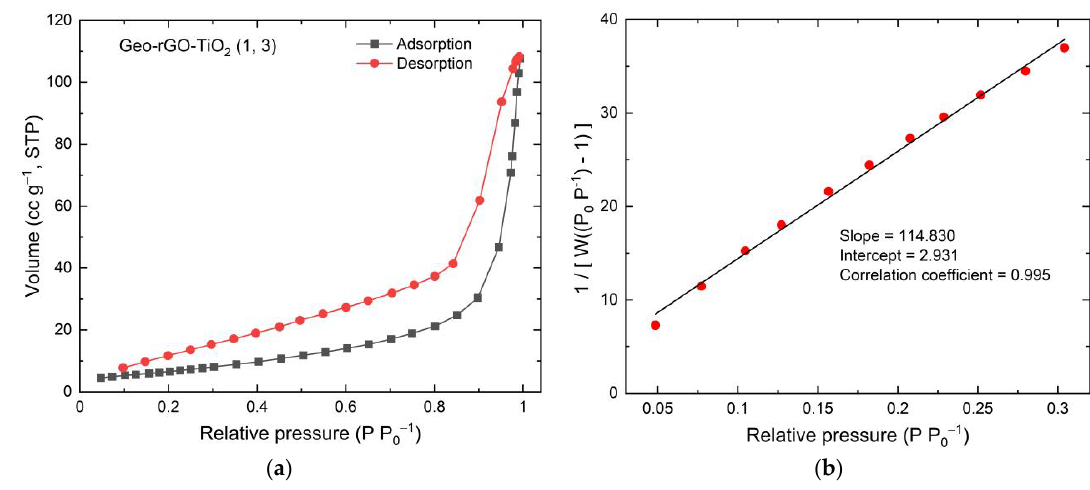
Figure 13. BET results of Geo–rGO–TiO 2 (1, 3) nanocomposite ( a ) isotherm, and ( b ) multi-point BET.